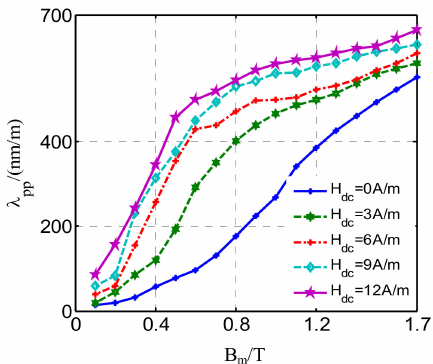
Figure 4. Magnetostriction curve under di ff erent DC-biased magnetizations ( H dc = 0 A / m, 3 A / m, 6 A / m, 9 A / m, 12 A /